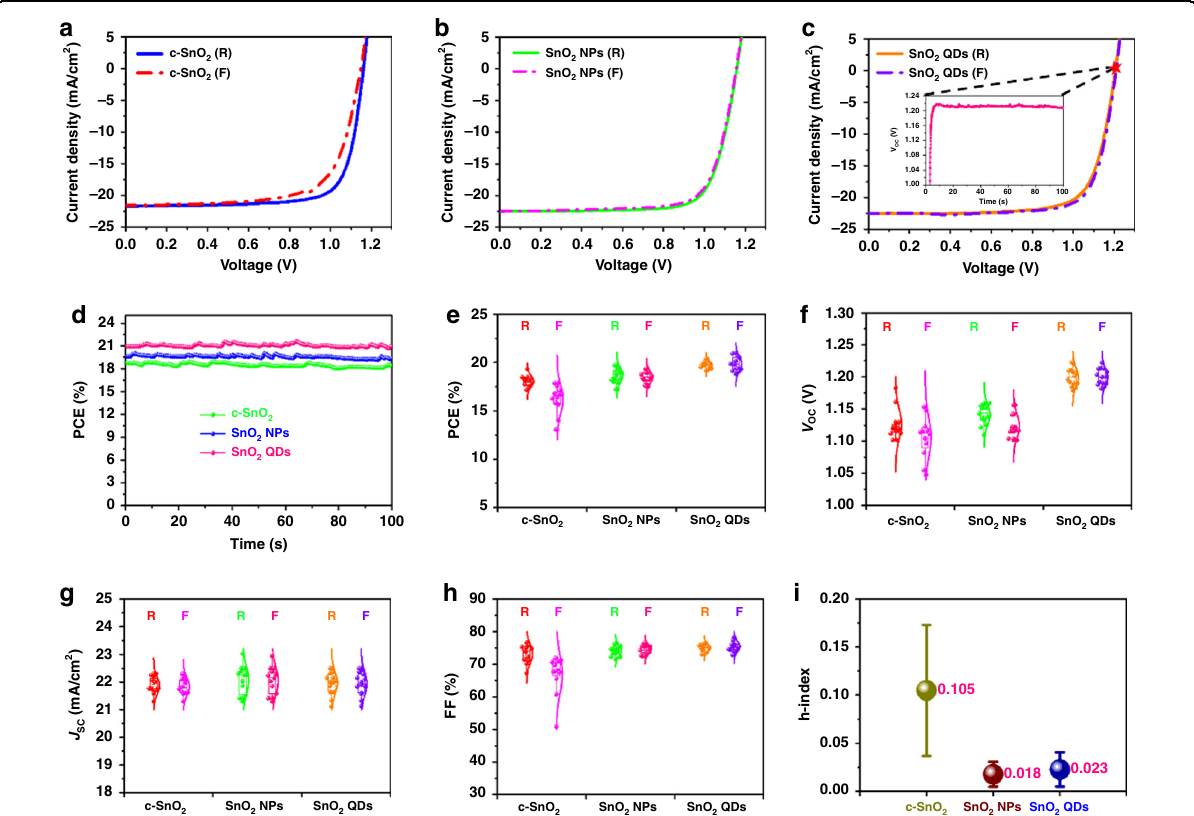
Fig. 5 Photovoltaic performance of PSCs. Best-performing J – V curves with reverse and forward scans of PSCs with a c-SnO 2 ETLs, b SnO 2 NPs ETLs, and c SnO 2 QDs ETLs. Inset: stabilized V oc as a function of the time. d Stabilized PCEs at the maximum power point under simulated solar illumination (AM1.5G, 100 mW cm − 2 ). Histograms of the device photovoltaic parameters e V oc , f J sc , g FF, and h PCE obtained from a batch of PSCs with different ETLs. i Average h-index with standard deviation extracted from J – V curves of PSCs with various